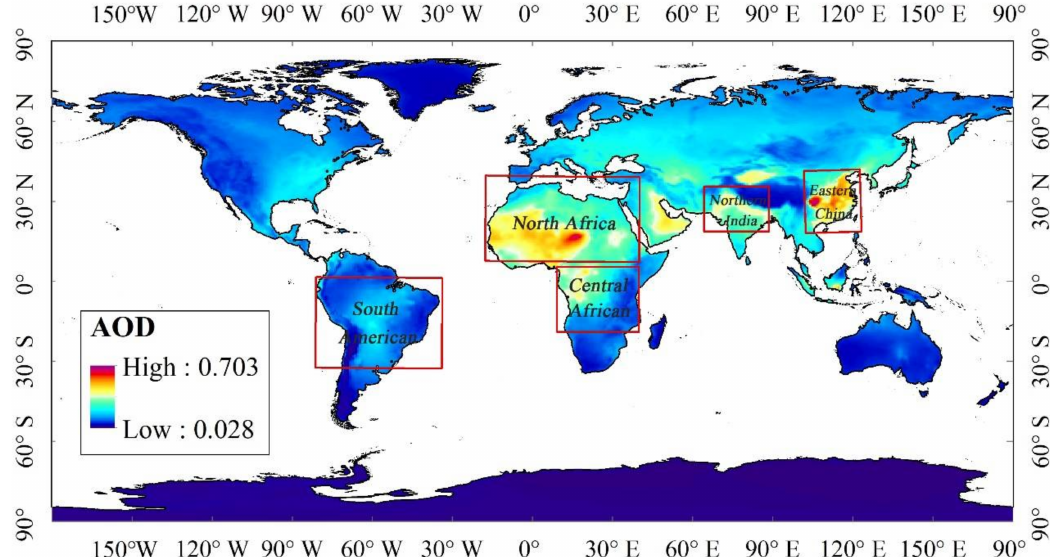
Figure 2. The global spatial distributions of annual mean AOD values during 1980–2018.